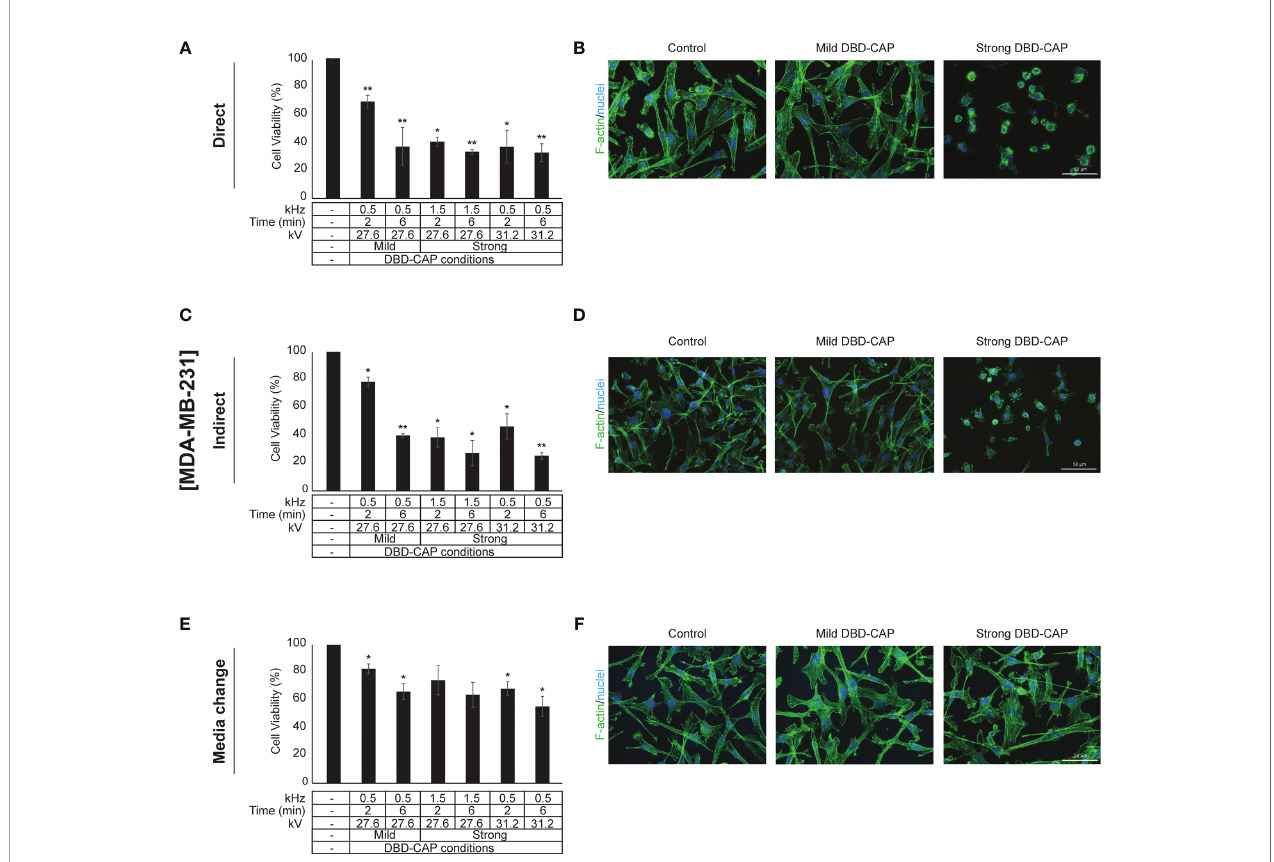
FIGURE 6 | DBD-CAP suppresses MDA-MB-231 (ER-, highly metastatic) breast cancer cell growth. (A, C, E) Assessment of % cell survival 24 h after treatment with mild (0.5 kHz/27.6 kV) or strong (1.5 kHz/27.6 kV or 0.5 kHz/31.2 kV) DBD-CAP (direct, indirect, media change) for 2 and 6 min. The values represent the mean ± SD of 3 (at least) independent experiments. Asterisks illustrate signi fi cant differences of the different treatment conditions compared to untreated (control) cells (* p < 0.05, ** p < 0.01). (B, D, F) Cell morphology after mild (0.5 kHz/27.6 kV) or strong (0.5 kHz/31.2 kV) DBD-CAP treatment for 2 min. Scale bars, 50 µm. Representative immuno fl uorescence images are shown ( F-actin , green; nuclei ,